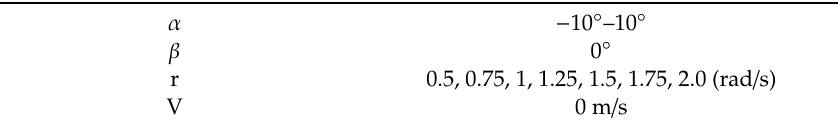
Table 8. Measurements of vertical force Y and pitching moment N at different angular velocities r.